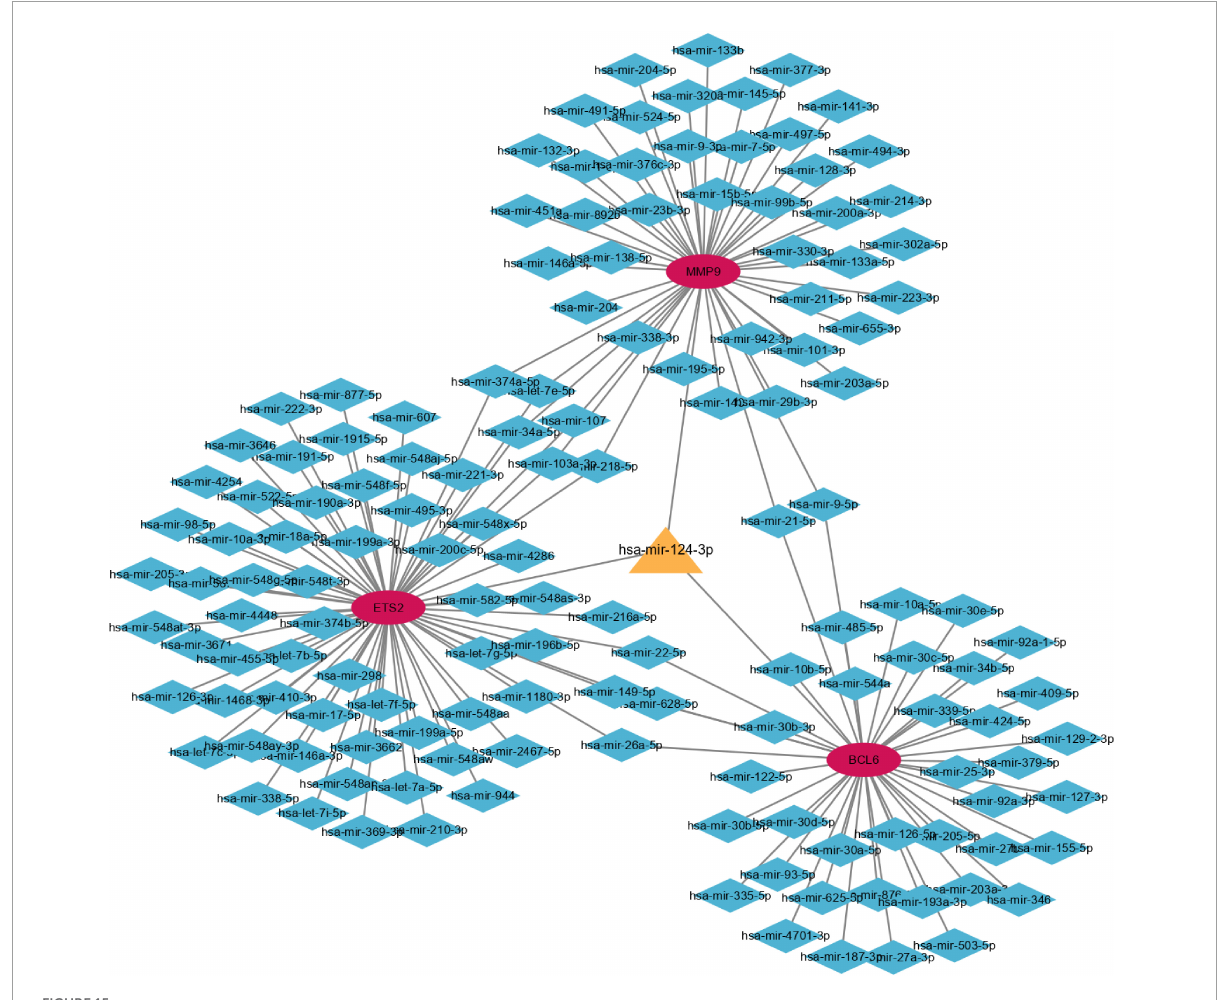
FIGURE15 Coexpression network of diagnostic genes and target miRNAs. Red ellipses represent diagnostic genes, and blue diamonds represent target miRNAs.